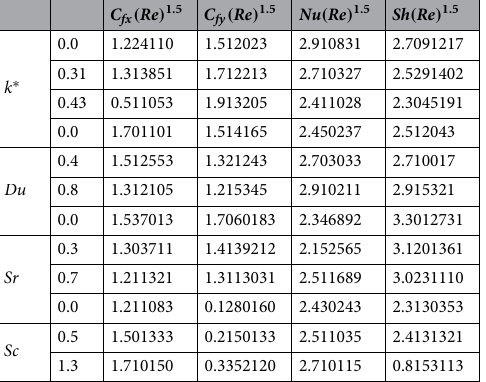
Table 6. Simulations of physical quantities when Du = 0.2, M = 0.5, Sr = 0.1, β = 0.2, Pr = 4, ( Gr ) c 0.3, K 0.1, β 0.2, Ec 0.001, Sc 5 and ( Gr ) t ∗ = ∗ = = = = =